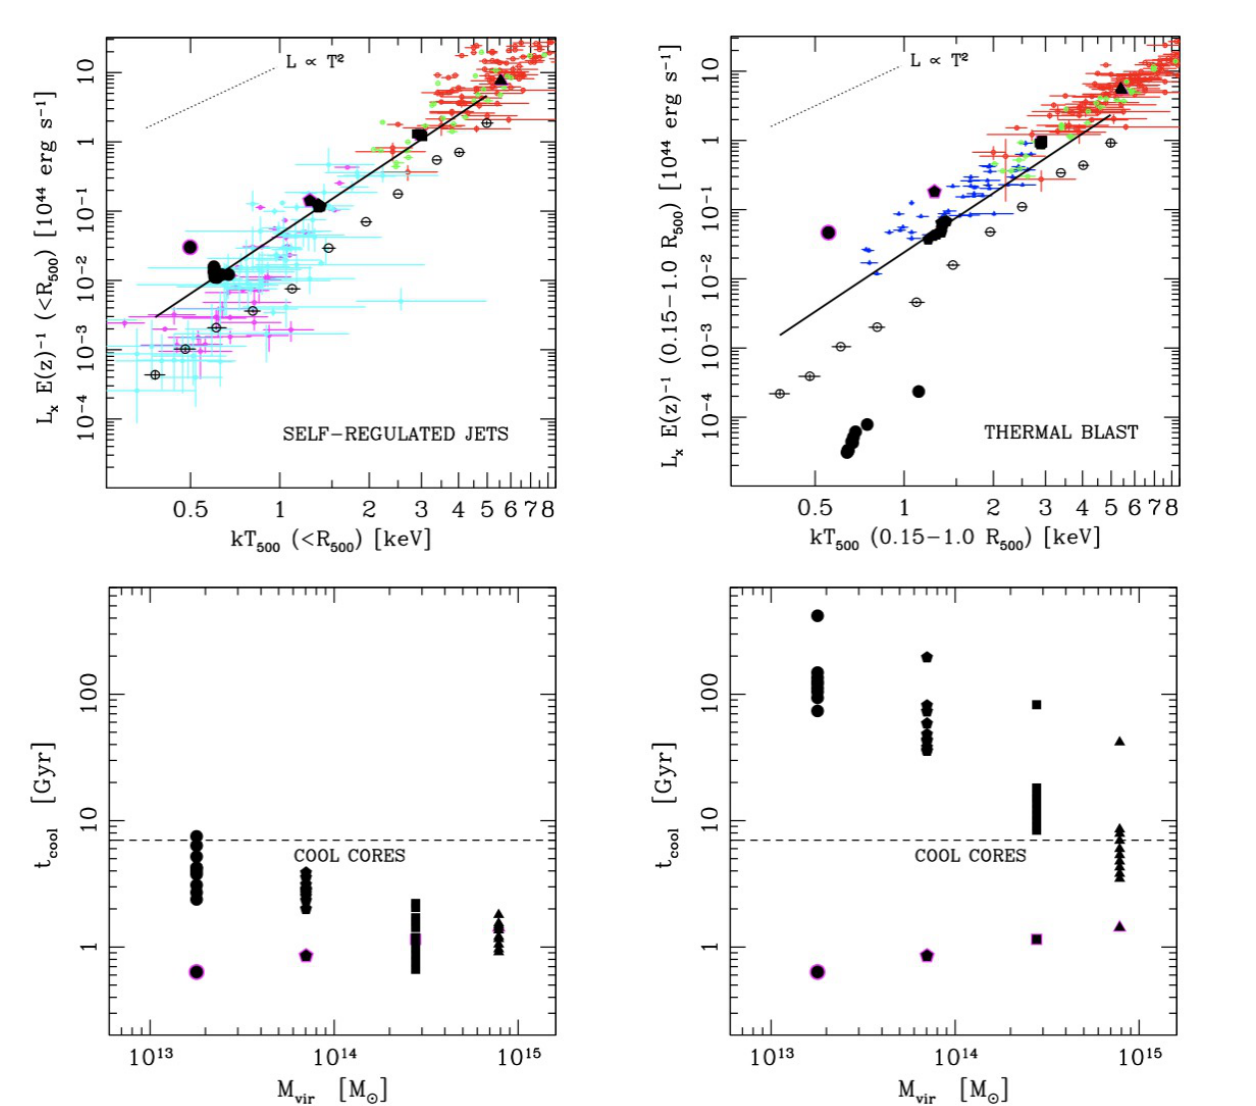
Figure 8. Effects of different baryonic models in shaping the evolution of the hot halos, in particular the X-ray luminosity–temperature relation ( top panels ) and cool-coreness via the central cooling time ( bottom panels ); adapted from Anderson et al. [103] and Gaspari et al. [27]. The colored individual objects in the top panels are from a wide range of obser- vational works (Helsdon and Ponman [92], Osmond and Ponman [94], Mulchaey et al. [218], Pratt et al. [30], Sun et al. [81], Maughan et al. [219]; luminosities are extracted mostly in the 0.5–2 keV band). The empty circles and solid line show the raw Anderson et al. [103] stacking analysis and the unbiased fit, respectively. The filled black points show evolutionary tracks in large-scale HD simulations (Gaspari et al. [27]) implementing self-regulated AGN jets ( left ) or strong thermal blast feedback ( right ), preserving or evacuating the surrounding diffuse gaseous halo, respectively. The initial state is marked with magenta contour. Evacuation and overheating becomes particularly dramatic in low-mass, less-bound